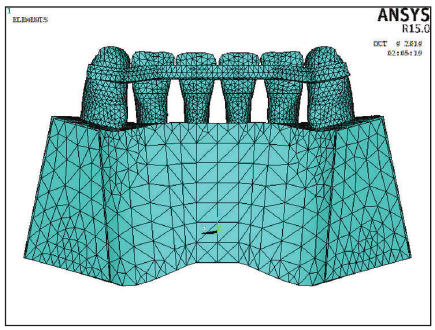
Figure 2: Model 2 in which FRC bonded to the upper third of lingual teeth